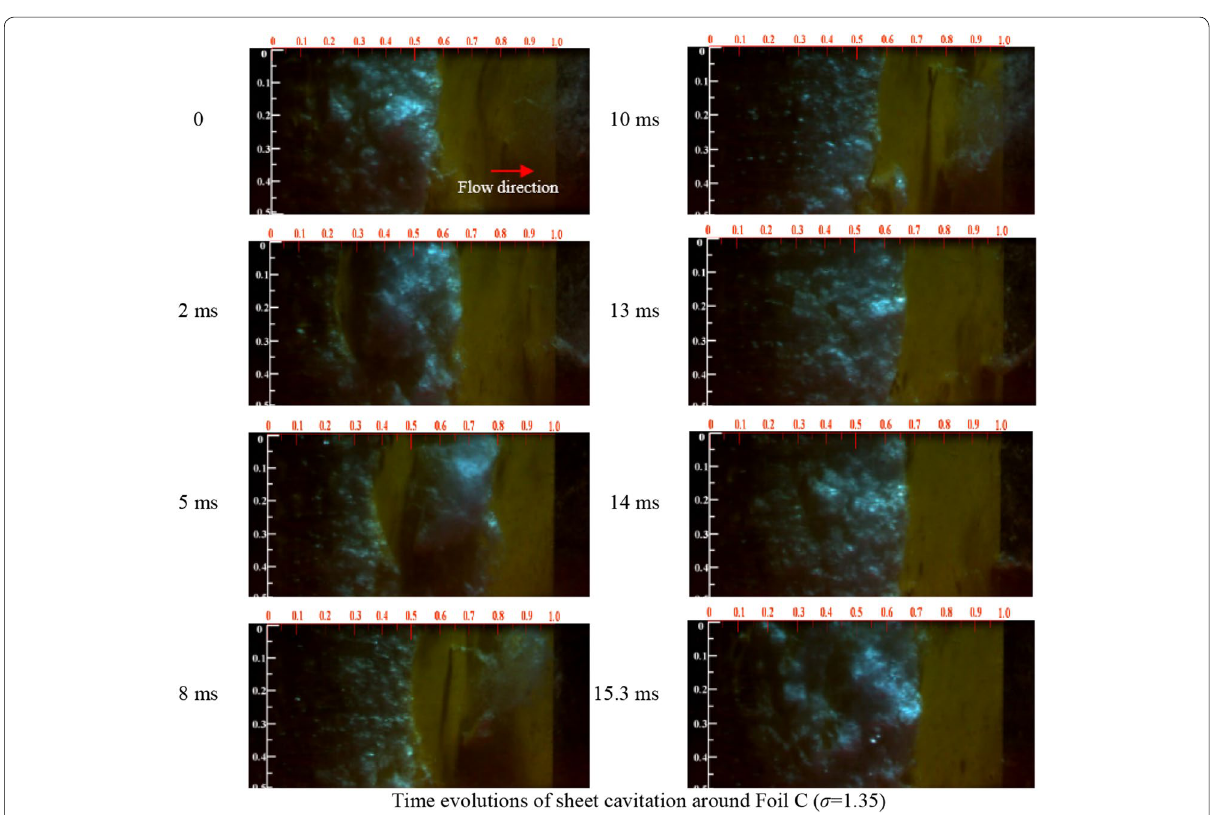
Figure 6 Time evolutions of sheet cavitation